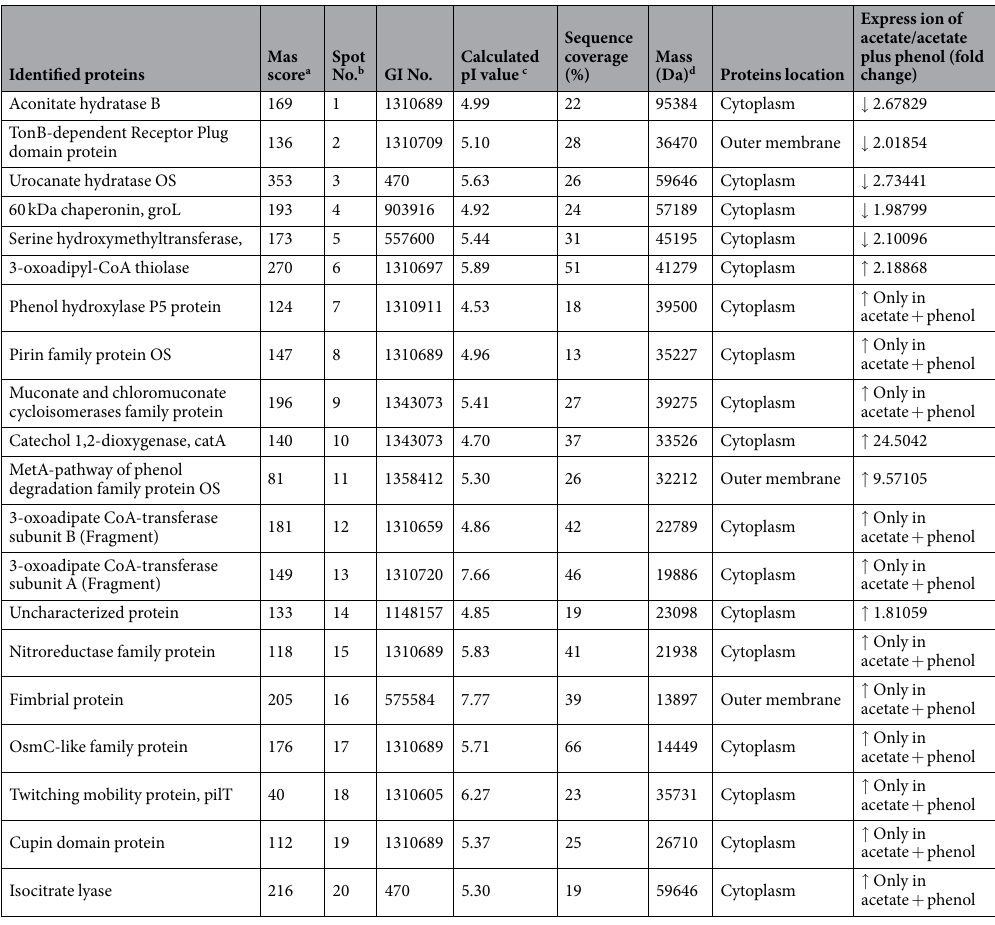
Table 3. Identification and characterization of differential expression proteins by MALDI/TOF/TOF MS between acetate or phenol as the sole carbon. a MOWSE scores of the highest confident matches (P < 0.05). b The number refers to the spot numbers as given in Fig. 6. c pI, the predicted isoelectric point calculated from the protein sequence. d The predicted molecular weight calculated from the protein